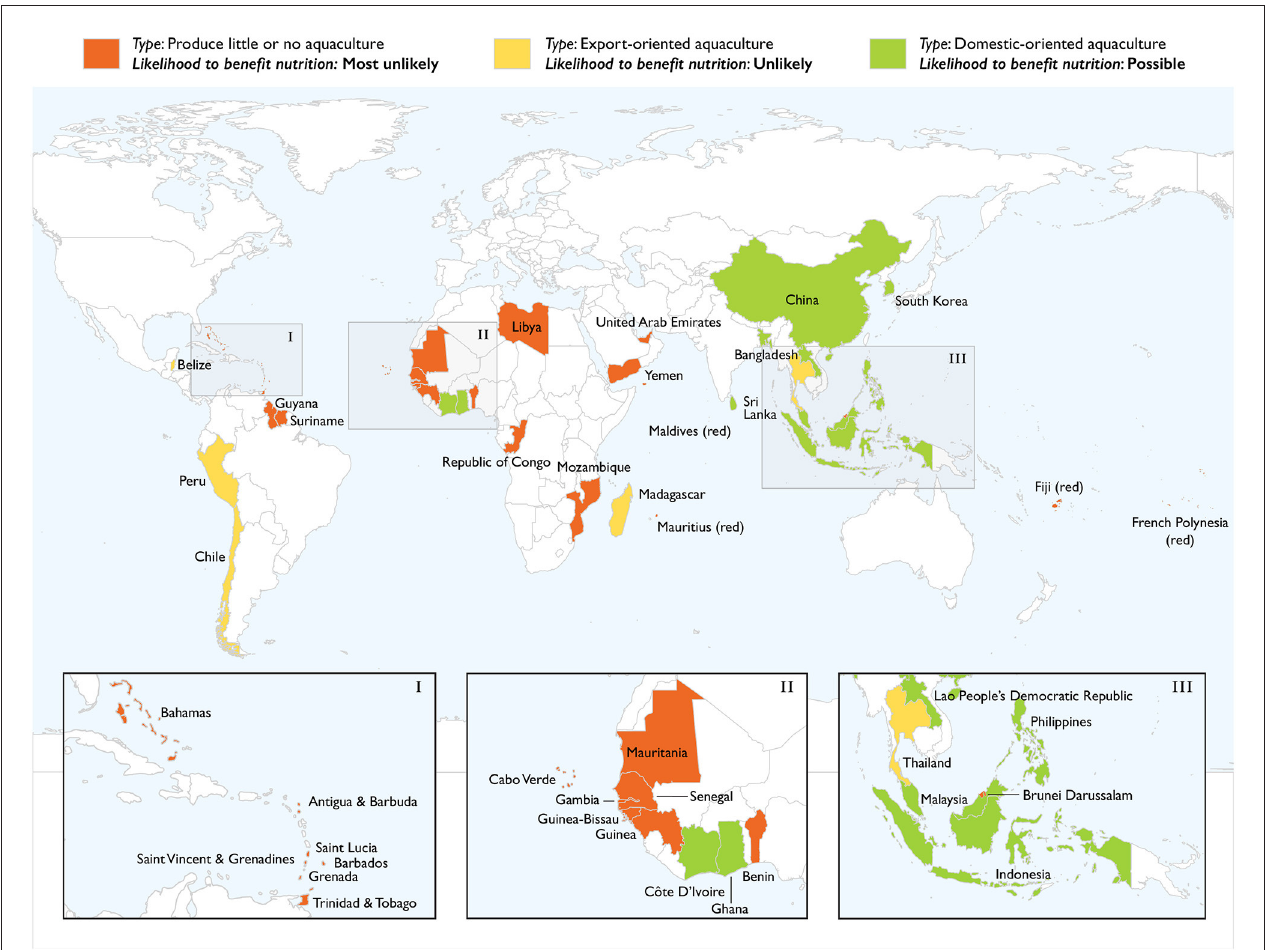
FIGURE 1 | In red, aquaculture, whether domestic or export-orientated, is currently too small to contribute to food security and nutrition. In yellow, aquaculture for export markets usually focus on high value species, and contribution to food security is unlikely via imports. Nutritionally vulnerable populations often do not benefit from multiplier effects of exports, and may feel shortages of local supply. In green, domestic aquaculture has mixed characteristics, and only those that focus on specific approaches and species are likely to contribute to food security. All other countries not deemed nutritionally vulnerable to wild capture marine fish catch declines were not